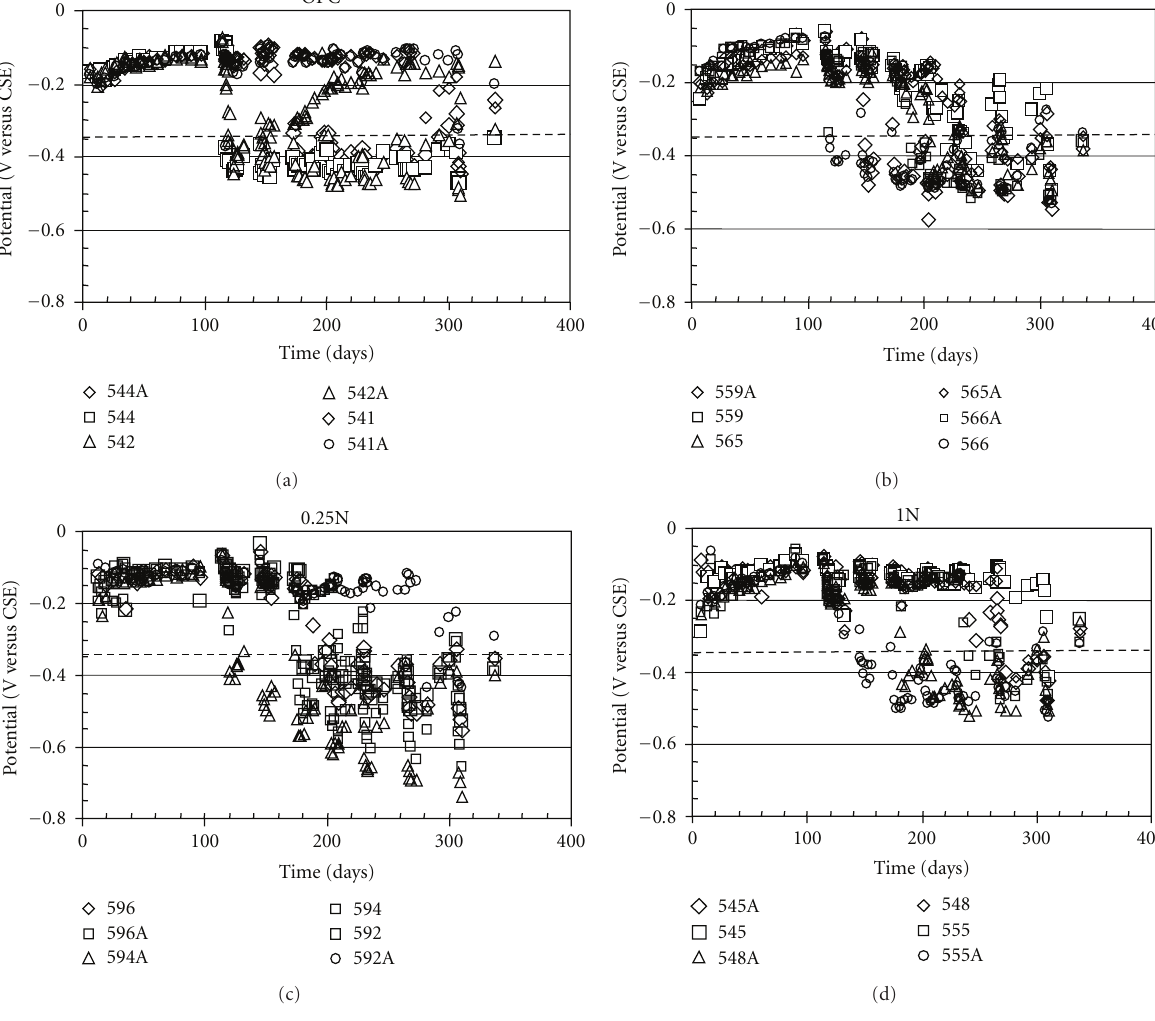
Figure 8: Half-cell potentials versus time of all second set of concrete specimens